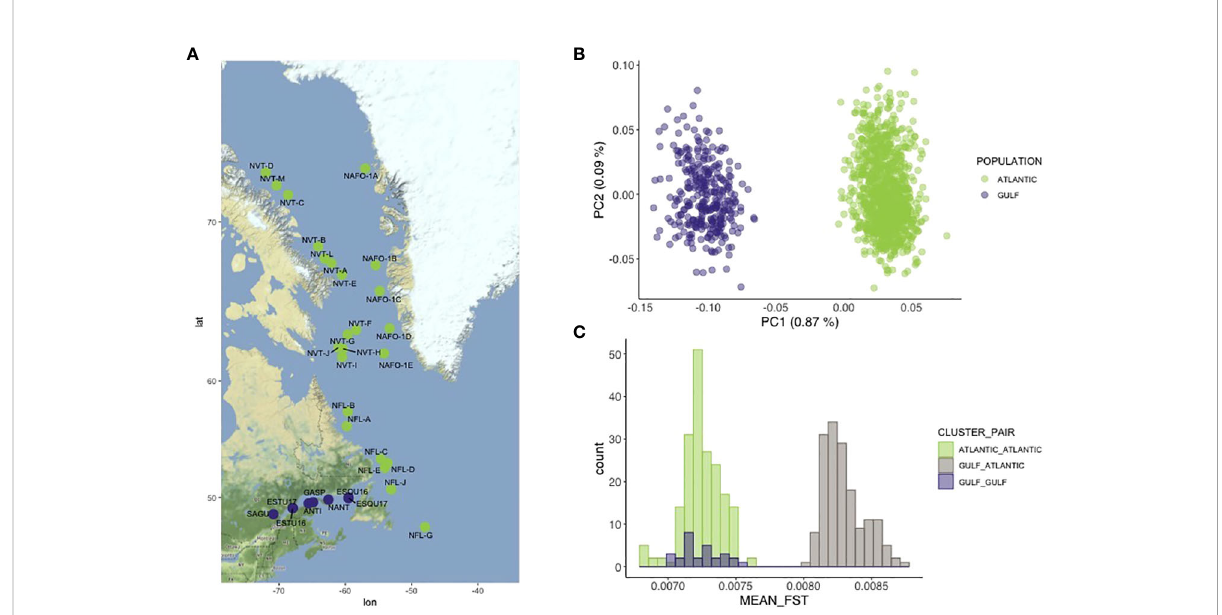
FIGURE 1 (A) Geographic locations of the 32 sampling sites studied across the Northwest Atlantic. Locations are colored according to PCA results discriminating locations form the Gulf of Saint Lawrence (purple) and locations from the rest of the Northwest Atlantic (green). (B) Two fi rst axis of the principal component analysis obtained without the 18 detected migrants (see main text for detail). (C) Distribution of the global mean pairwise Fst estimated across all sampling